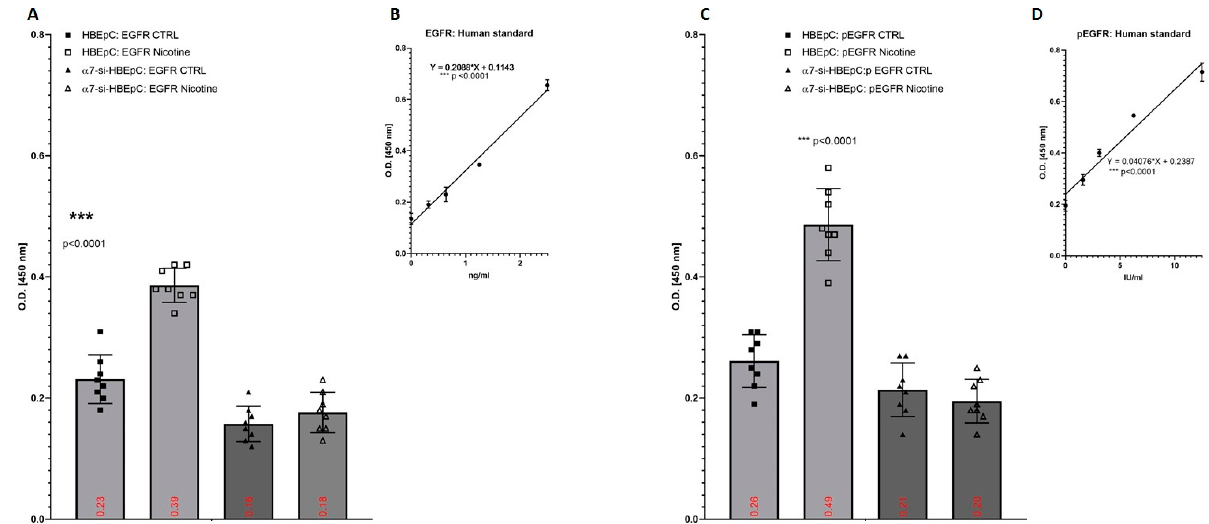
Figure 6. Expression of EGF and p-EGFR after exposure to nicotine for 48 h in HBEpC. ( A ): ELISA experiments for EGFR; ( B ): regression equation linearity for EGFR, performed with Prism; ( C ): ELISA experiments for p-EGFR; ( D ): regression equation linearity for p-EGFR, performed with Prism. Statistical significance is analyzed with one-way ANOVA with multiple-comparison and post hoc test with Bonferroni correction. Experiments are performed at least two times in triplicate.